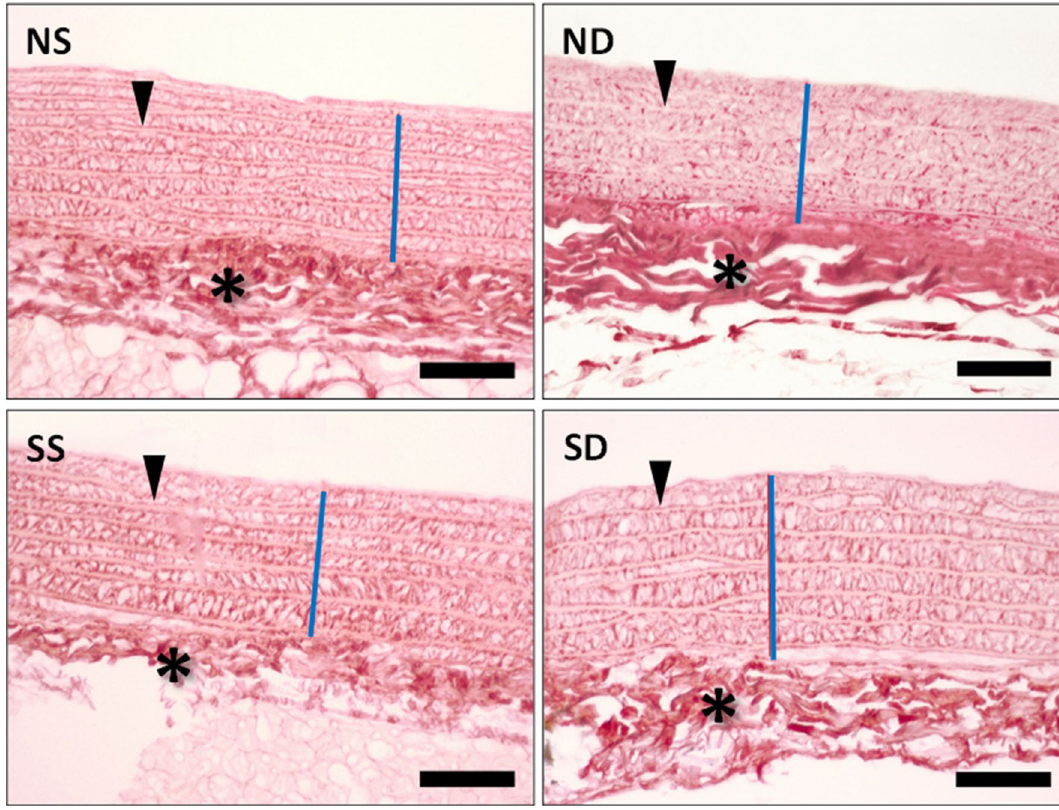
Figure 6. Representative images obtained from picrosirius-stained transverse aortic tissue sections from normotensive rats submitted to sham surgery (NS) or to renal denervation (ND), sham-operated spontaneous hypertensive rats (HS) or spontaneous hypertensive rats undergoing renal denervation (HD). Picrosirius staining demonstrates collagen in red and shows the typical histological organization of a normal aorta in all sections. The tunica media (blue lines) shows thin collagenous fibers interspersed among organized layers of smooth muscle cells and elastic lamellae (arrowheads). The tunica adventitia (asterisks) typically display coarse collagen fibers. Note that there is no difference between the groups for aorta morphology. Scale bars represent 50